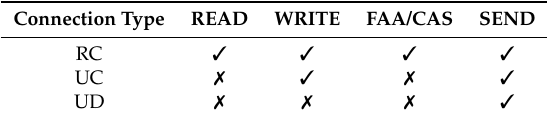
Table 2. Supported operations in each connection